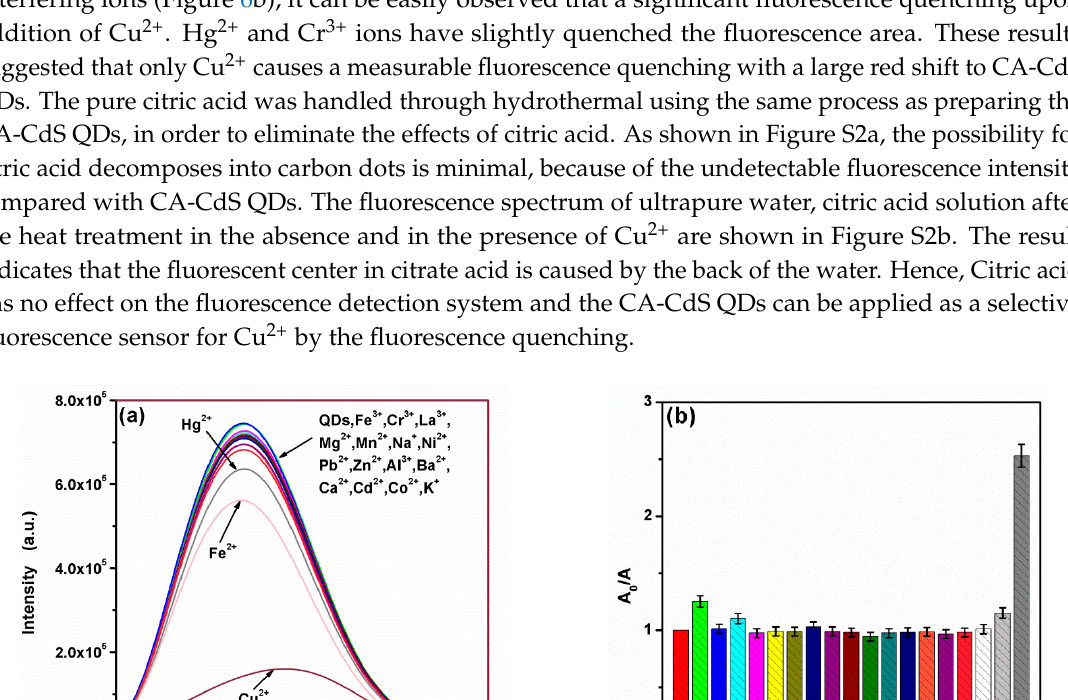
Figure 5. ( a ) The UV-vis absorbance (red line), the emission spectra (blue line) of the as-synthesized CA-CdS QDs. ( b ) ( α h υ ) 2 vs . h υ plot of CdS QDs for the determination of band gap. ( c ) The excitation-dependent emission spectra of CA-CdS QDs and ( d ) The CIE 1931 coordinates.